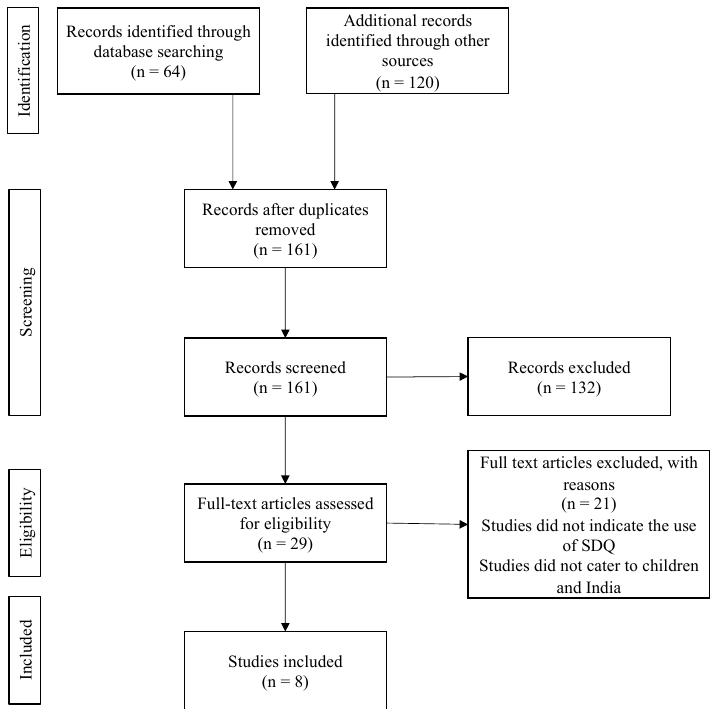
Figure 2. PRISMA diagram of studies included in the comprehensive scoping review for the SDQ.